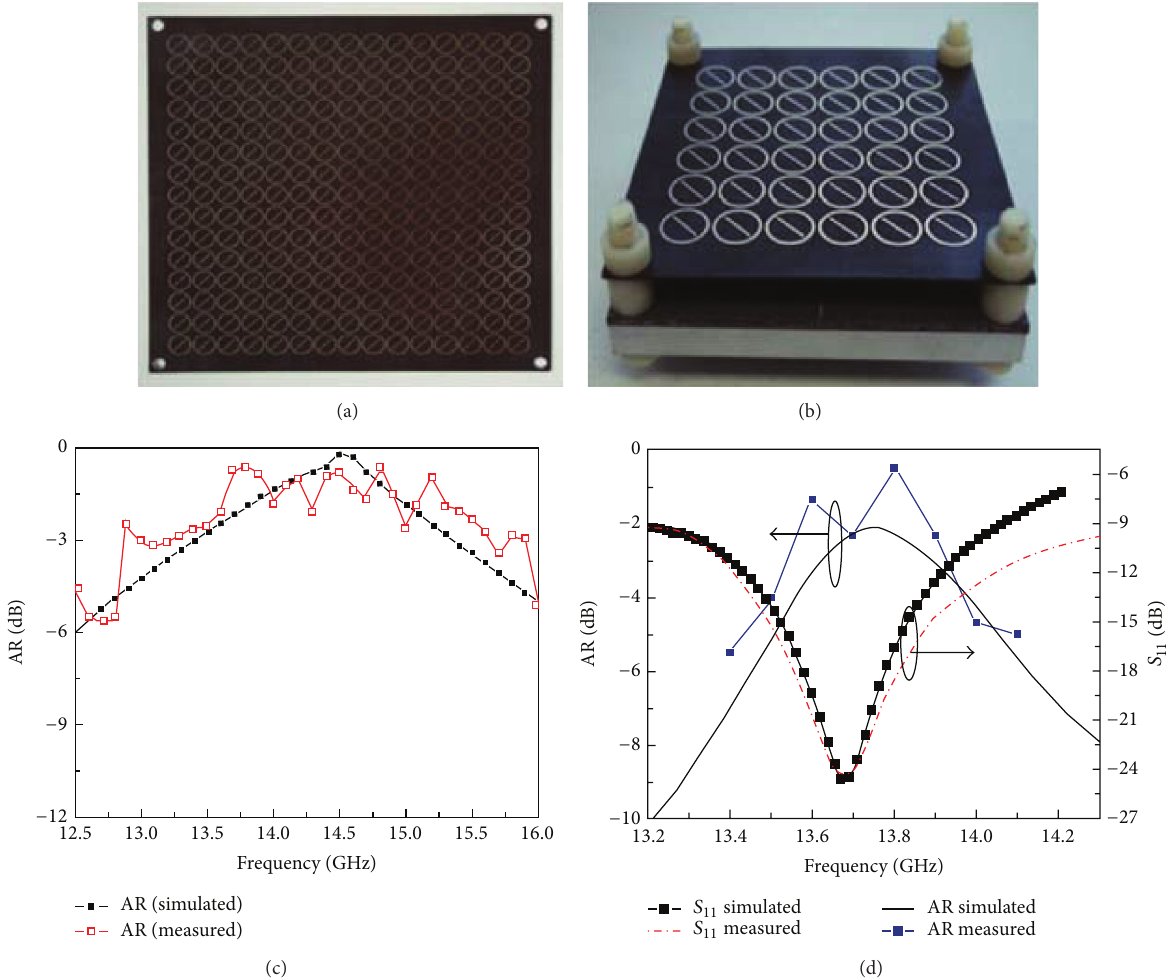
Figure 8: Photograph of the (a) fabricated polarizer and (b) high-gain circularly polarized patch antenna. (c, d) Measured and simulated AR for the polarizer and the antenna, respectively. Figures are reproduced from